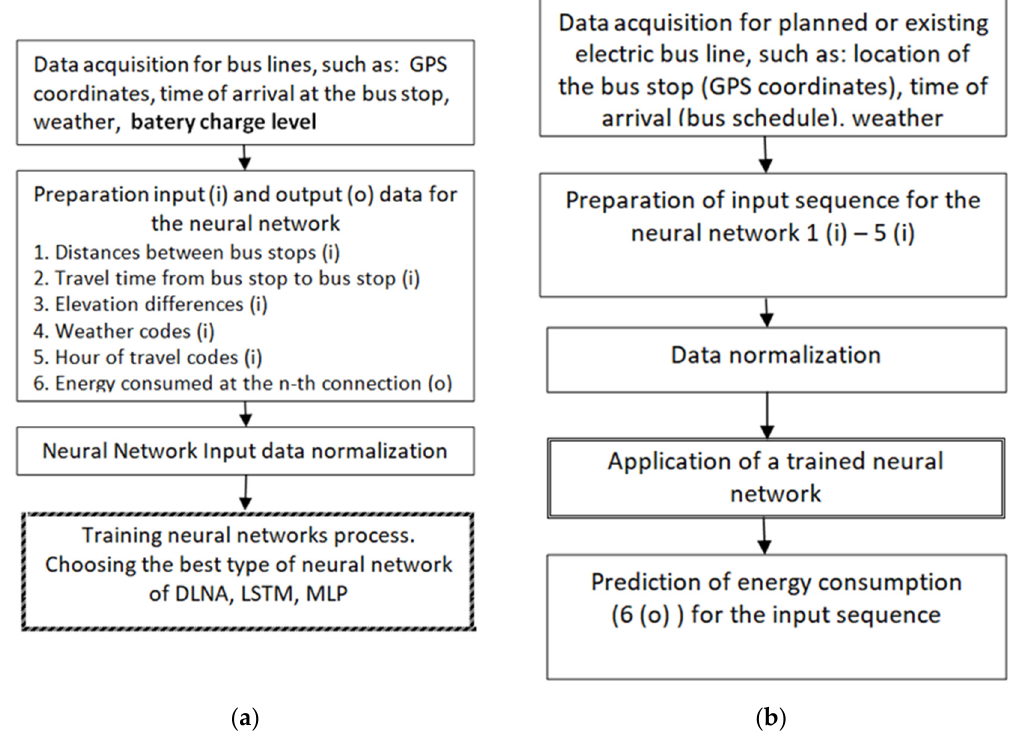
Figure 5. Methodology—Diagram of the method of predicting energy demand of an electric bus; ( a ) data acquisition and neural networks configuration; ( b ) model validation.